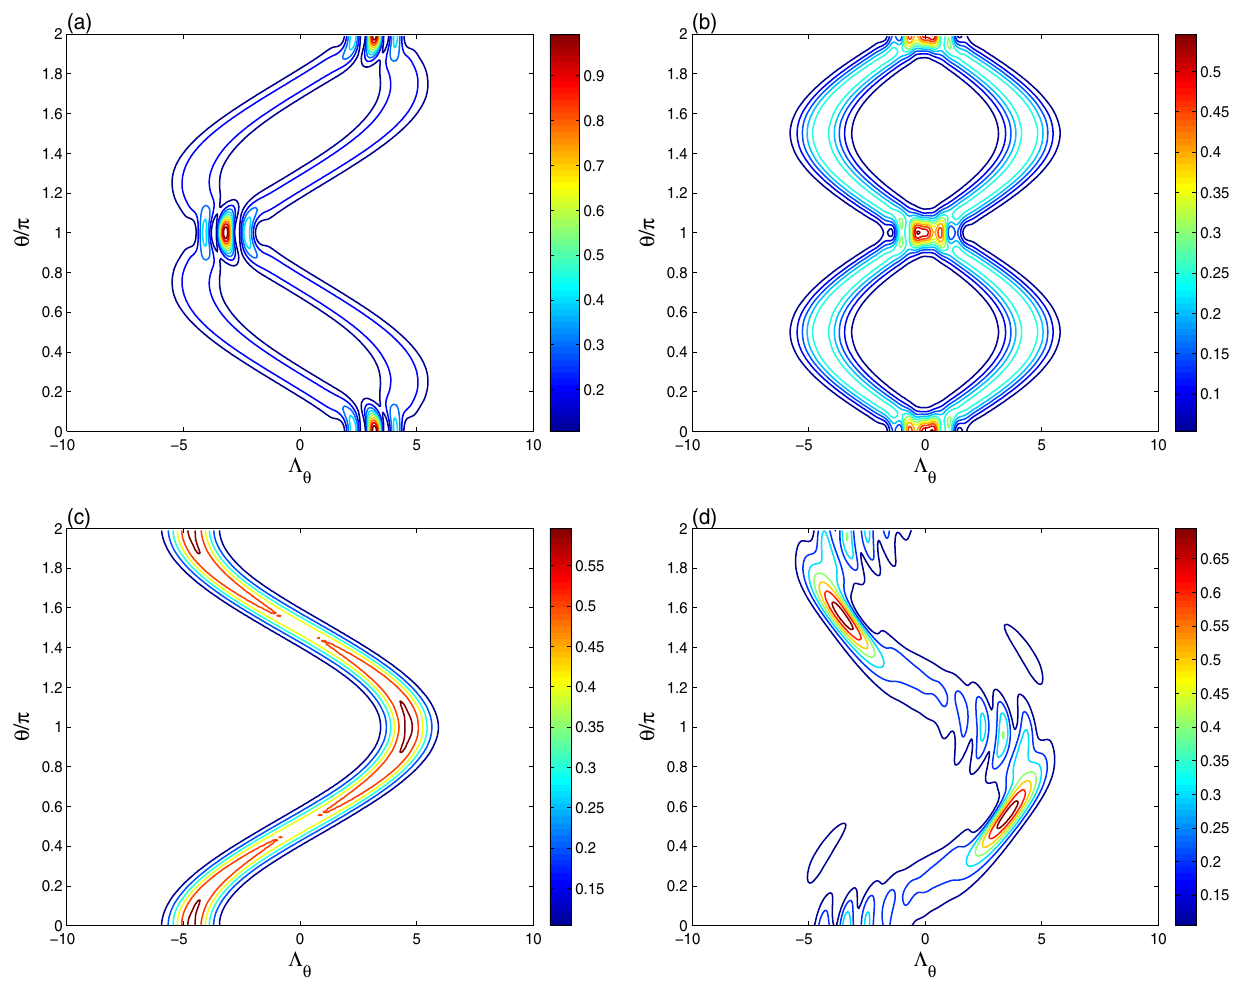
Figure 2. The dynamics of the optical tomography contour of the initial coherent state for | α | different times is represented at (cid:31) t = tomography of ( c ) under the detuning effect δ = 10 (cid:31) is plotted.